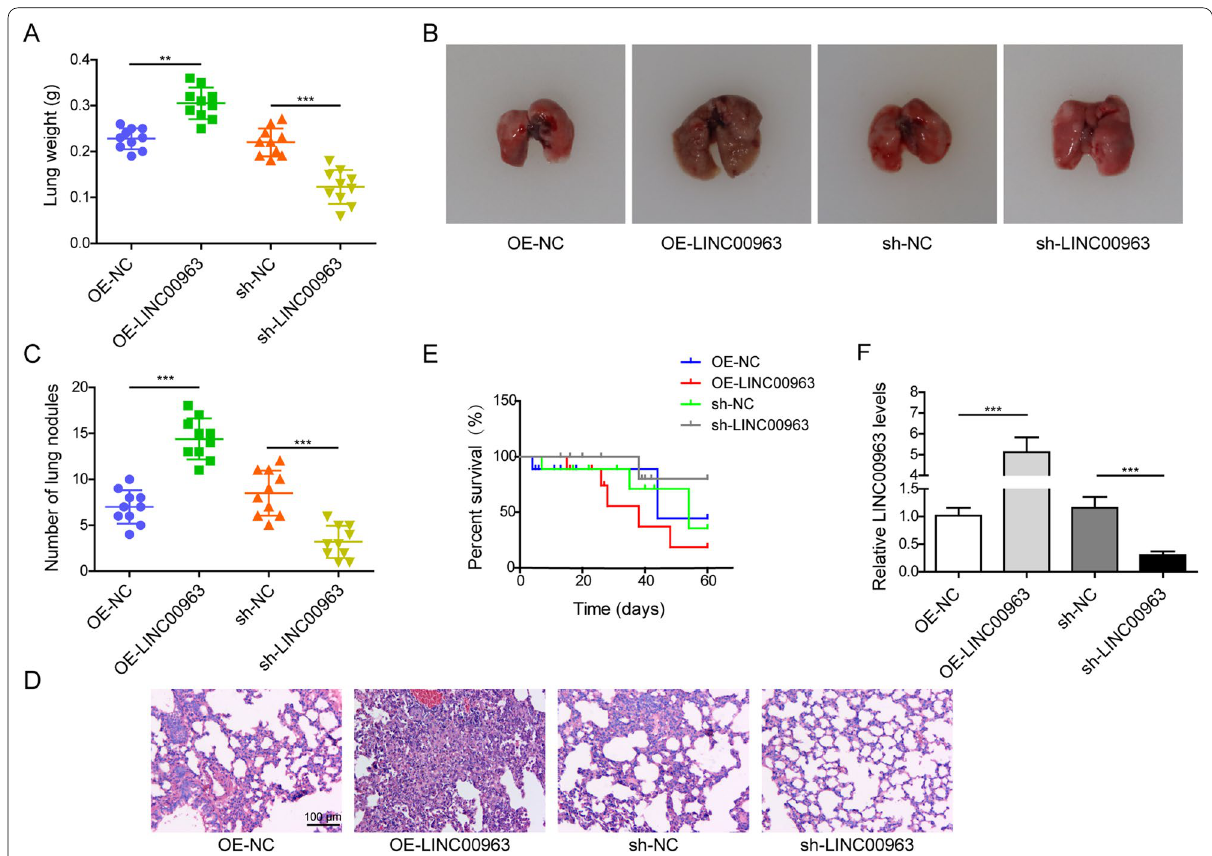
Fig. 4 LINC00963 crucially enhanced tumor metastasis in vivo. A549 cells with LINC00963 overexpression or silence were injected intravenously into nude mice. A The weights of lung tissues were measured between indicated groups of mice. B Photographs were taken on lung tissues from indicated groups. C The number of lung metastatic nodules was analyzed between indicated groups of mice. D The HE staining was performed on lung tissues from indicated groups. Scale bar: 100 μm. E The overall survival was compared between indicated groups using Kaplan–Meier method. F LINC00963 level was measured by RT-qPCR in lung tissues from indicated groups. ** P < 0.01 and *** P <